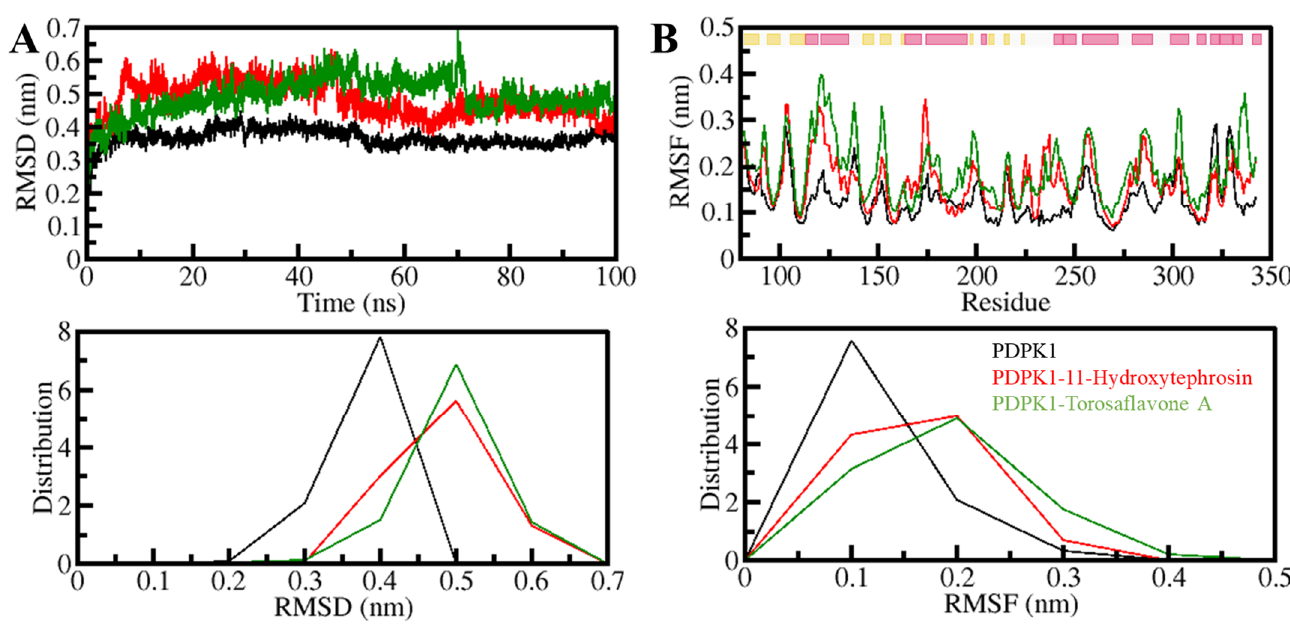
Figure 3. The structural dynamics of PDPK1 upon 11-Hydroxytephrosin and Torosaflavone A binding. ( A ) The RMSD plot of PDPK1 in complex with 11-Hydroxytephrosin and Torosaflavone A. ( B ) The RMSF plot of PDPK1 and its complex with 11-Hydroxytephrosin and Torosaflavone A. The top band at the RMSF plot shows the secondary structure assignments in PDPK1 where the sheet and helix are represented by yellow and pink, respectively. The lower panels show the value distribution as PDF.